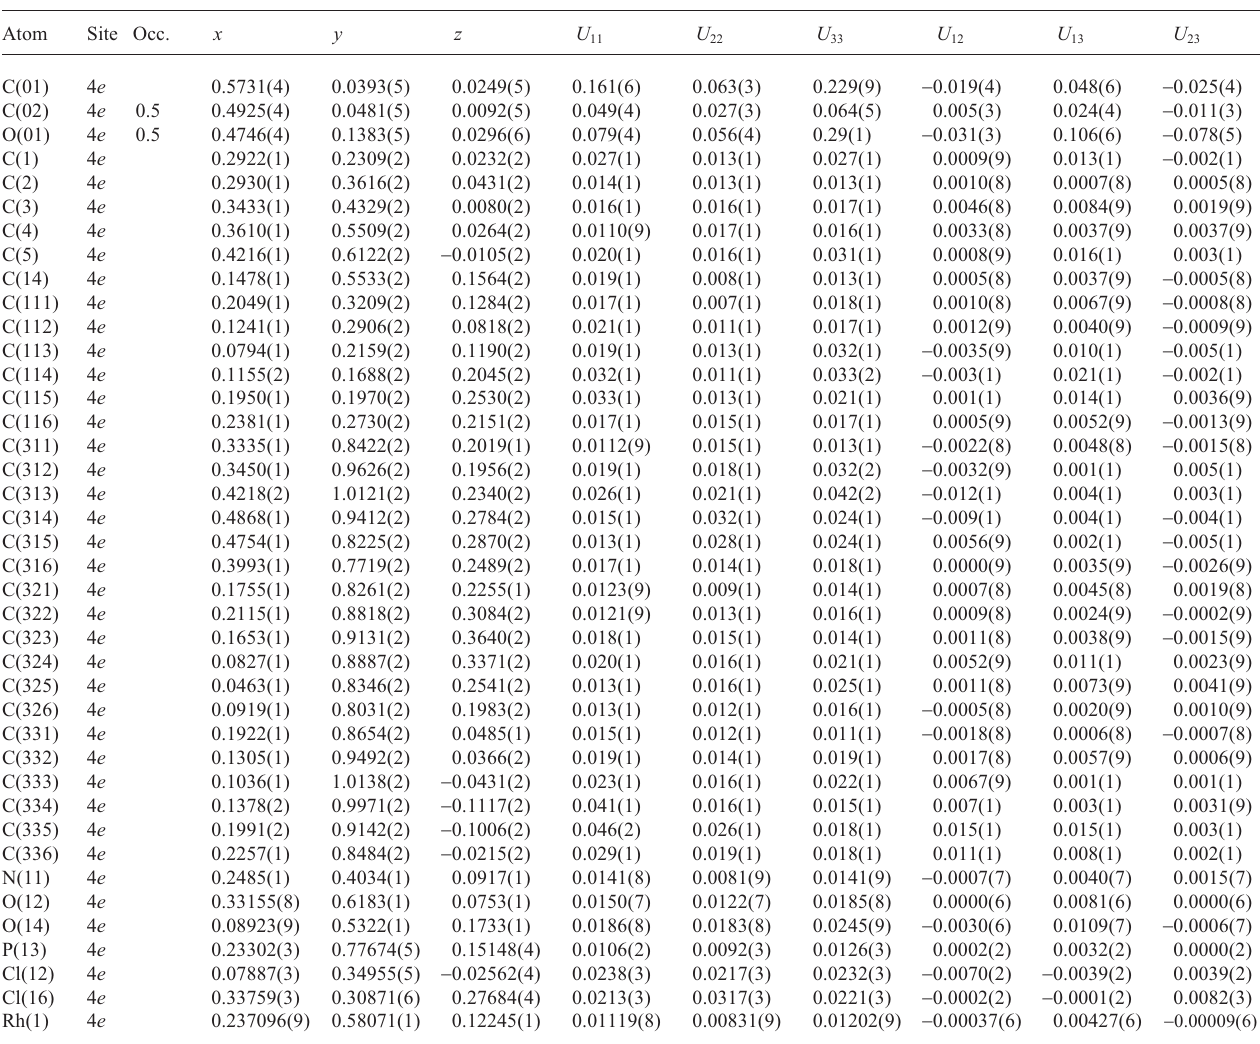
Table 3. Atomic coordinates and displacement parameters (in Å 2 )